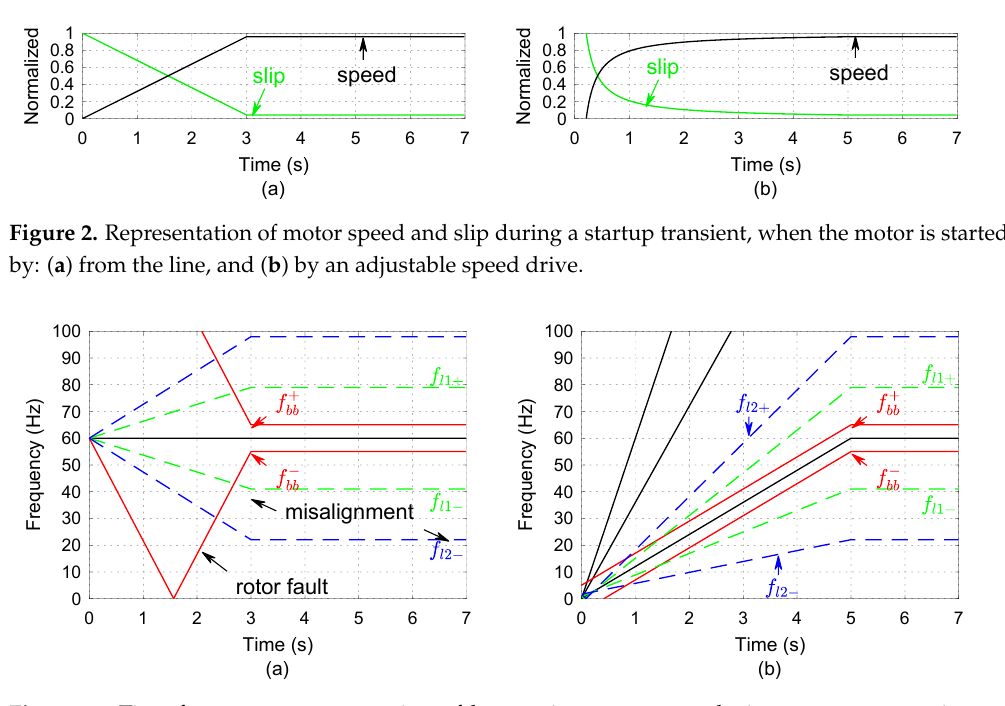
Figure 3. Time-frequency representation of harmonic components during a startup transient of an induction motor fed: ( a ) from the line, and ( b ) by an adjustable speed